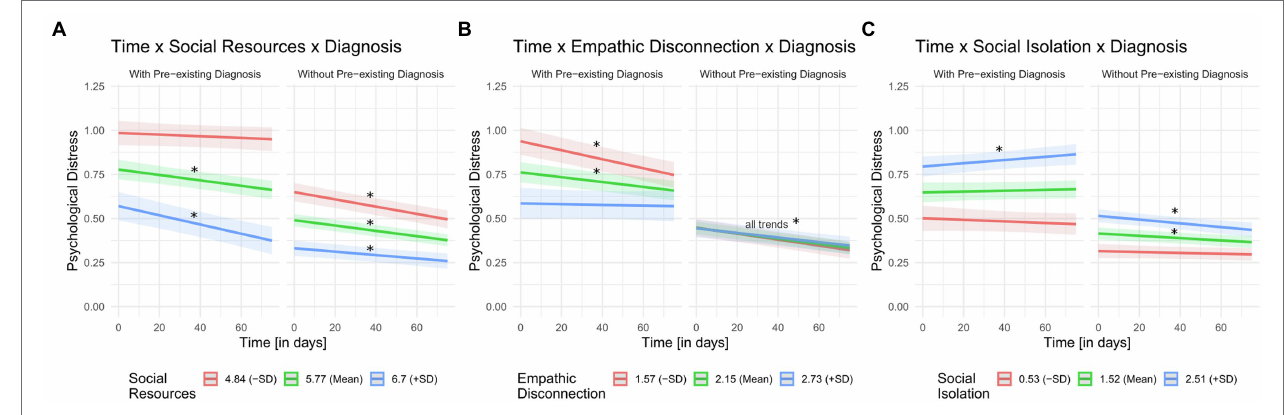
FIGURE 2 | Three-way interactions between time, current, or preceding diagnosis of a mental disorder and (A) social resources, (B) empathic disconnection, and (C) social isolation. For visual purposes, we split the continuous moderator variables (A) social resources, (B) empathic disconnection, and (C) social isolation into mean and mean ±one SD to plot interaction terms. Also for visual purposes, time variable and social moderator variables were not standardized. Standardization vs. not standardization of variables did not have an effect on the displayed results. * means significant time trend ( p < 0.01). Shaded areas represent 95% confidence